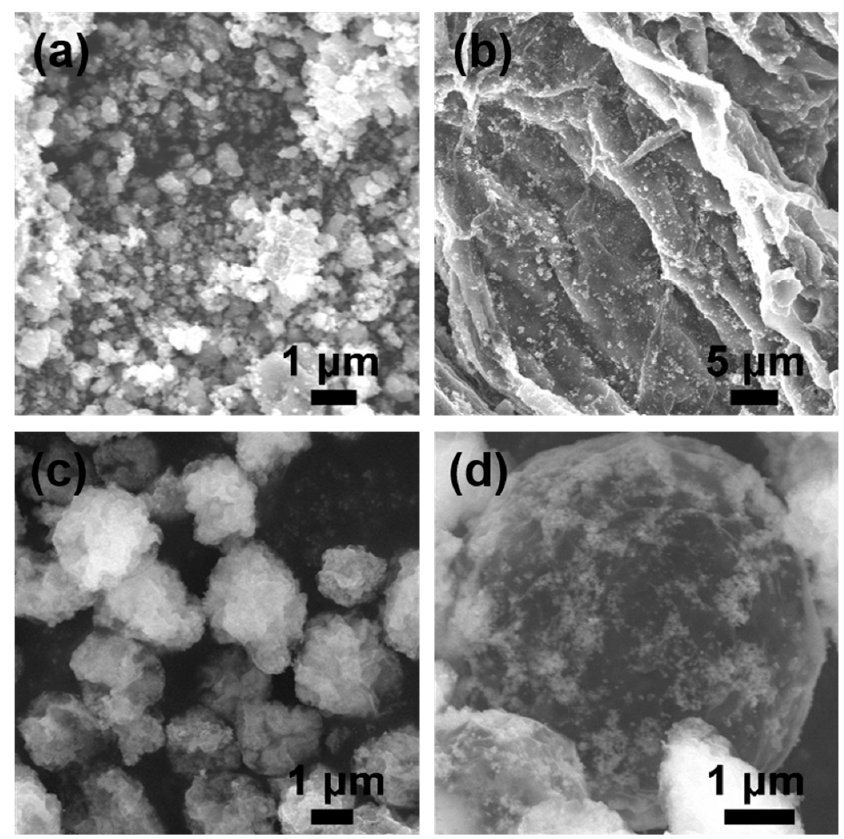
Figure 2. SEM images of ( a ) pure ZnO; ( b ) ZnO/rGO; ( c , d ) 3D-ZnO/rGO.